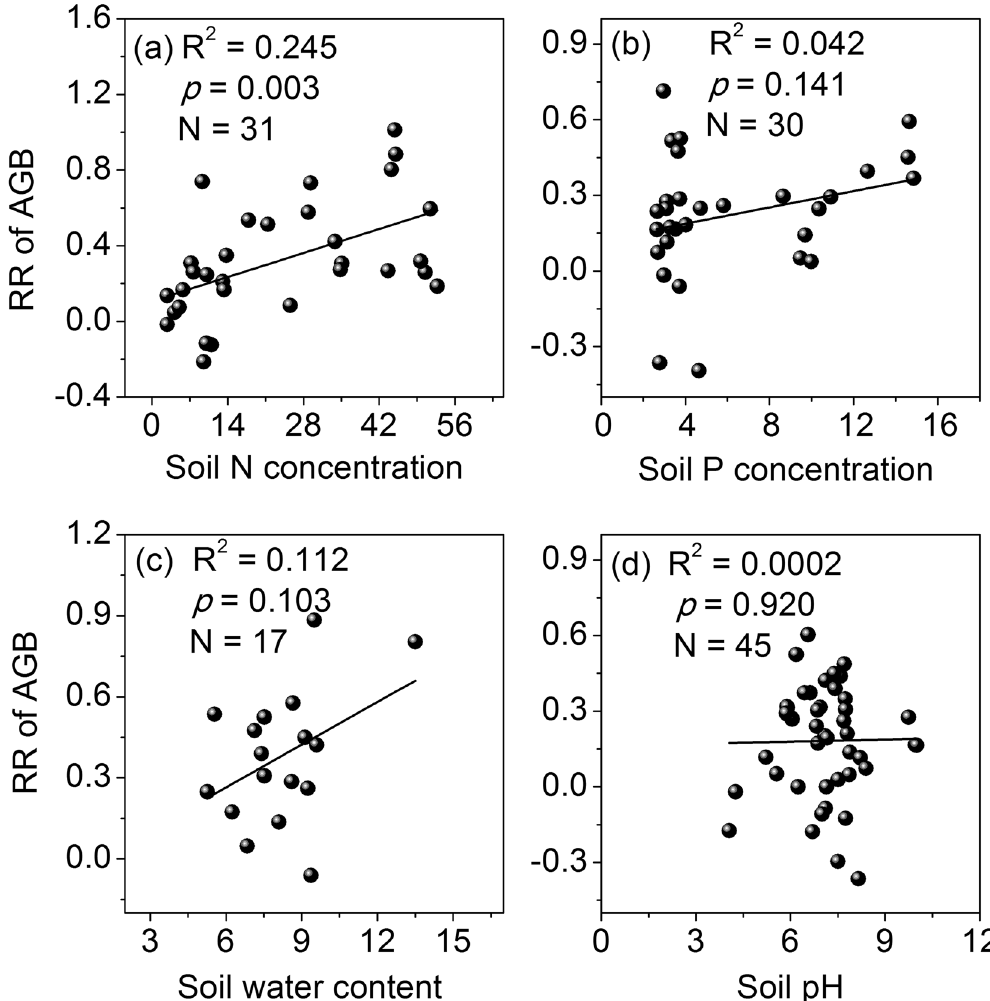
Figure 4. Relationships between the response ratio (RR) of the aboveground biomass (AGB) and the soil available nitrogen (N) concentrations (mg − 1 kg) ( a ), soil available phosphorus (P) concentrations (mg − 1 kg) ( b ), soil water content (v/V%) ( c ), and soil pH ( d